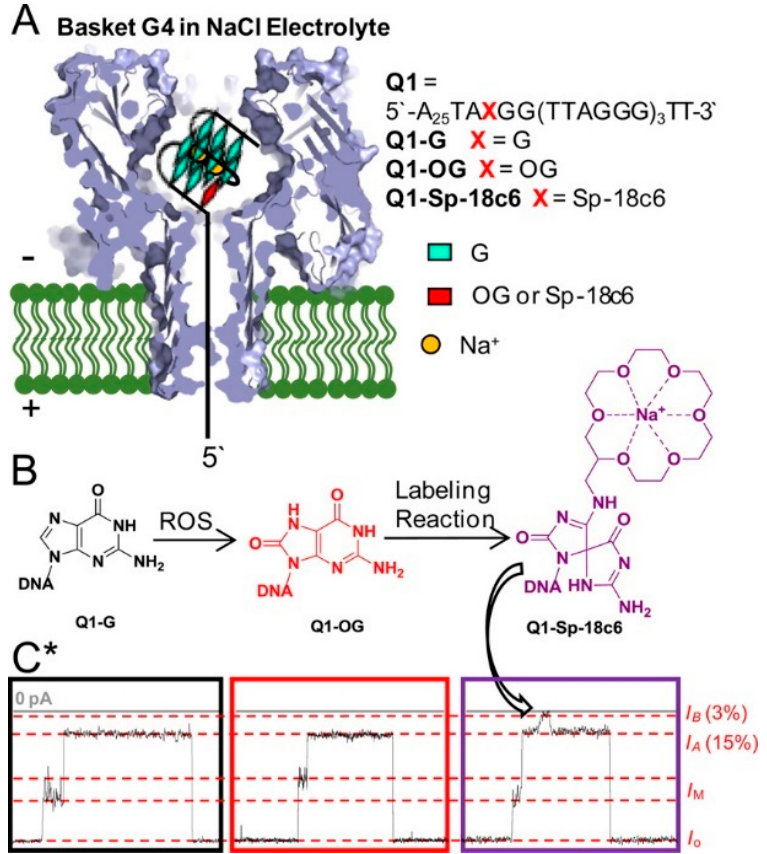
Figure 15. The schematic representation of α -hemolysin ( α -HL) nanopore technology to detect OG. ( A ) Scheme for experimental setup, including the G4 sequence studied and location of the OG and Sp-18c6-labeled OG. ( B ) Reaction scheme for G conversion to OG by ROS, followed by labeling of OG with aminomethyl-18c6 (18c6) in the presence of the mild one-electron oxidant K2IrBr6 to furnish the labeled OG product, Sp-18c6. ( C ) Current vs time traces for Q1-G (black box, left), Q1-OG (red box, middle), and Q1-Sp-18c6 (purple box, right). Reprinted with permission from Reference [46]. © 2015, American Chemical